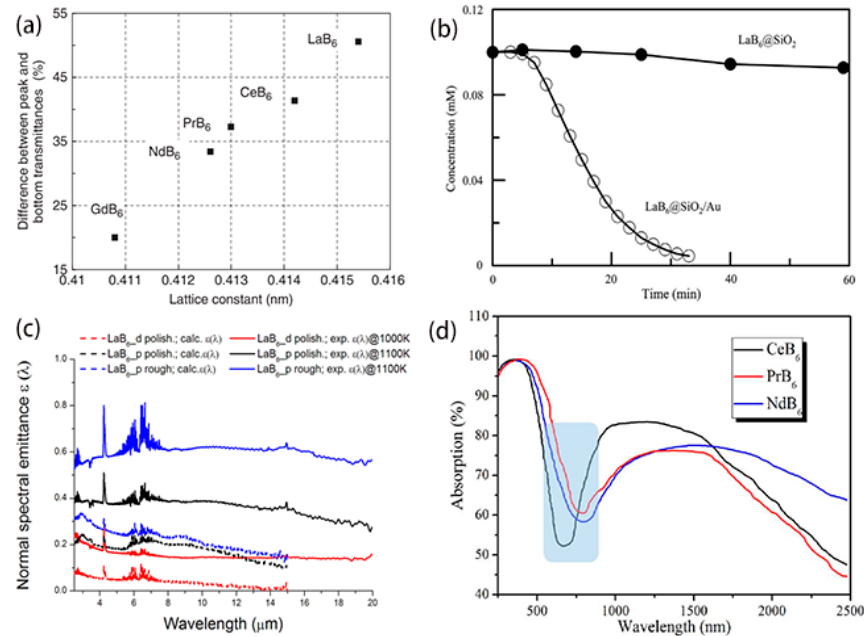
Figure 15. ( a ) Near-infrared absorption of rare-earth hexaboride nanoparticles with regard to their lattice constants [85]. Copyright 2008, Wiley. ( b ) Variation of 4-nitrophenol concentration with time by LaB 6 @SiO 2 and LaB 6 @SiO 2 /Au composite nanoparticles [88]. Copyright 2013, Elsevier. ( c ) Calculated (dashed lines) and experimental emittance (solid lines) of LaB 6 samples [89]. Copyright 2017, Springer Nature. ( d ) The optical absorption of REB 6 nanostructures at visible and near-infrared ranges [90]. Copyright 2017, Elsevier.